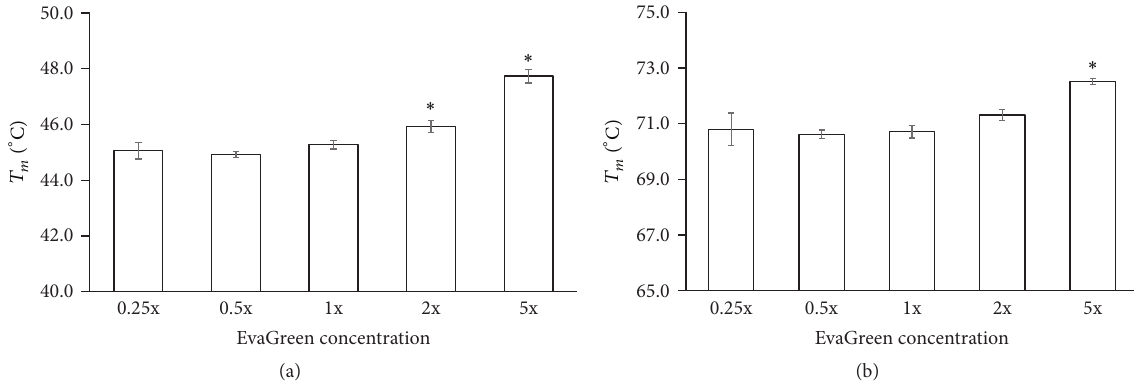
Figure 2: Effect of EvaGreen concentration on 𝑇 𝑚 of DNA duplex by HRM. DNA duplexes GC3/15 (a) or GC12/15 (b) of 1 𝜇 M were measured in the solution with 0.25x, 0.5x, 1x, 2x, or 5x EvaGreen, 10mM phosphate (pH 7.4), and 100mM NaCl. Comparisons were done using one-way ANOVA analysis; ∗ 𝑃 < 0.05 versus “0.05x” ( 𝑛 = 6